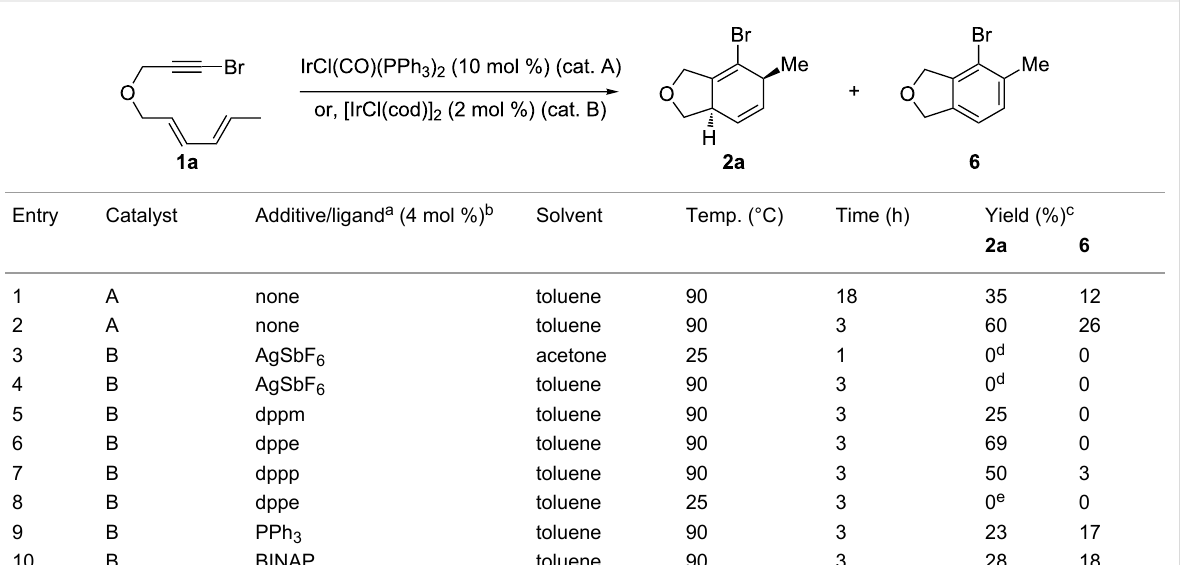
Table 1: Optimization of iridium-catalyst for [4 + 2] cycloaddition of alkynyl bromide 1a